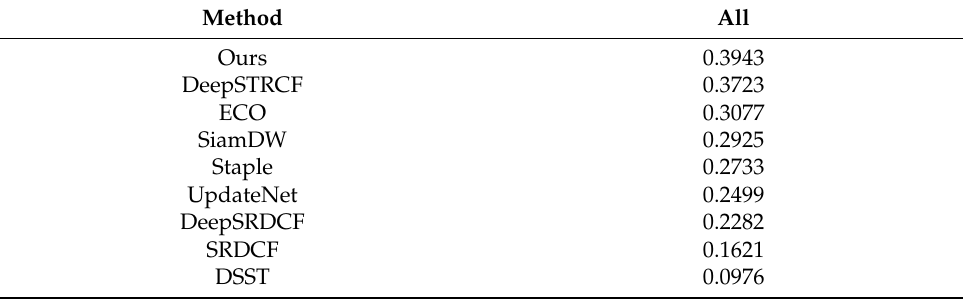
Table 4. The EAO rank among all compared